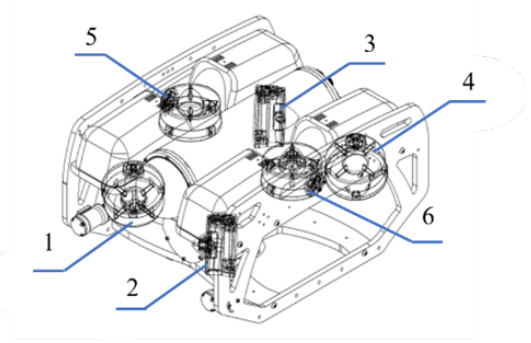
Figure 7. A schematic of the AUV used in numerical simulations and experiments, where 6 thrusters are indexed from 1 to 6.